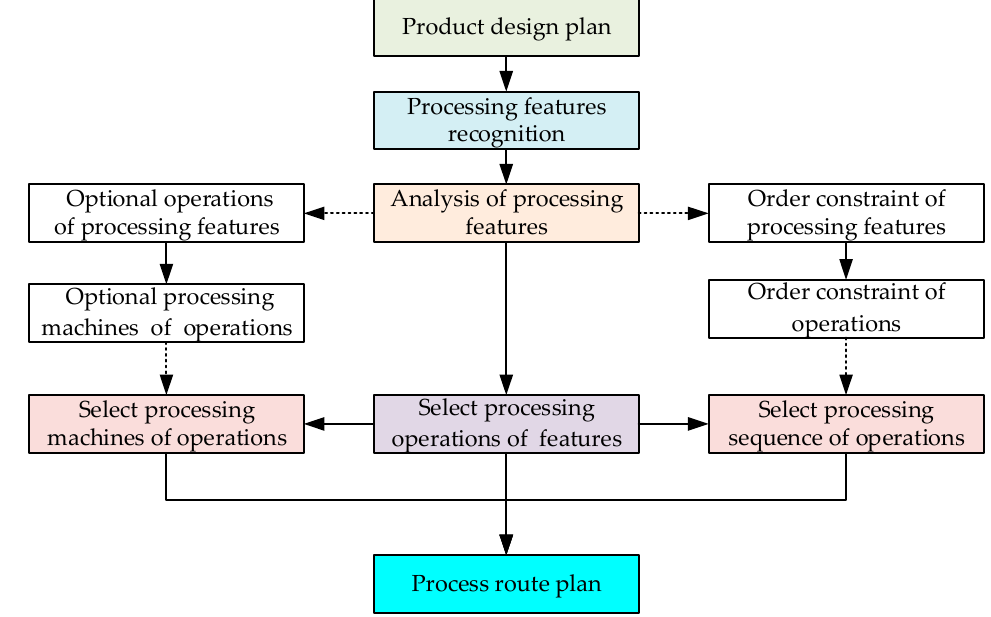
Figure 2. The procedure of process planning activity.